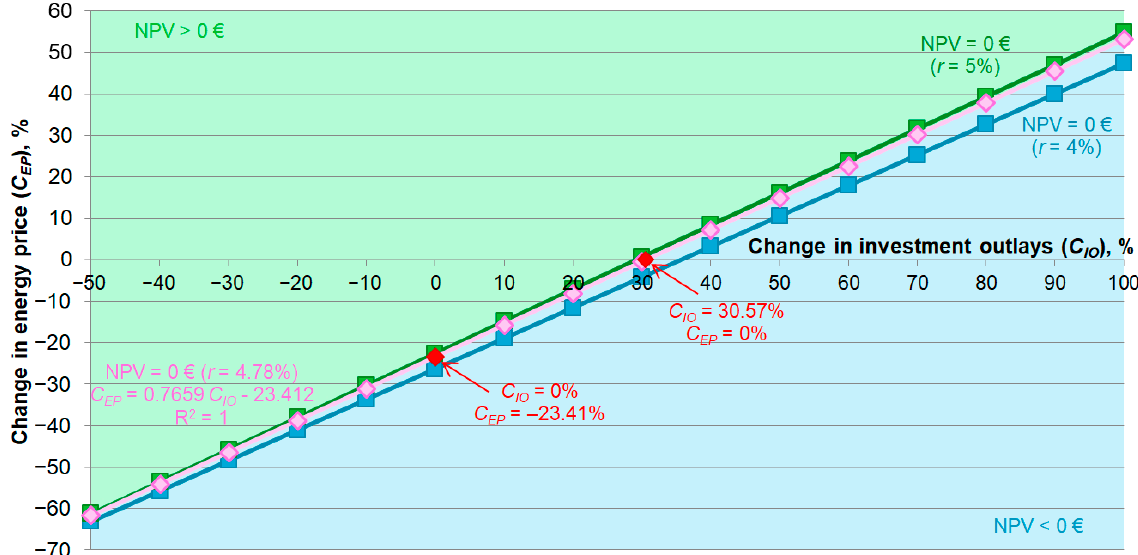
Figure 12. The results of the two-factor sensitivity analysis on the percentage changes in energy prices and investment outlays. prices and investment